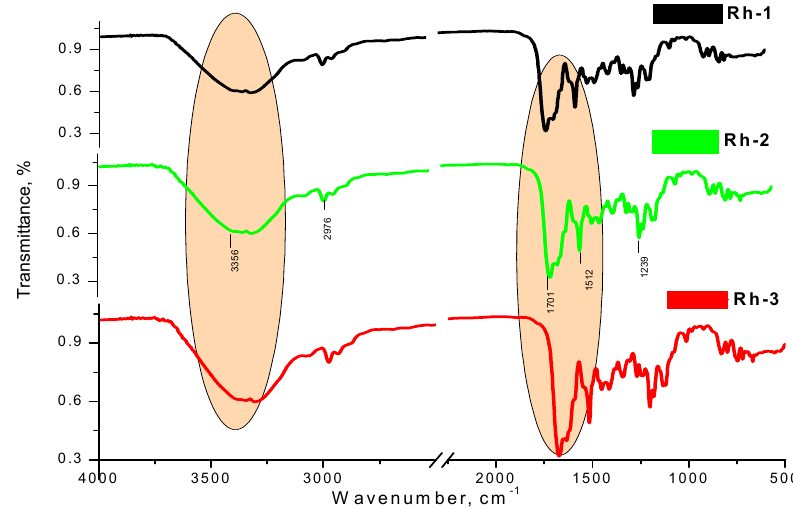
Figure 8 . IR-spectra of the rhodamine-peptide derivatives.